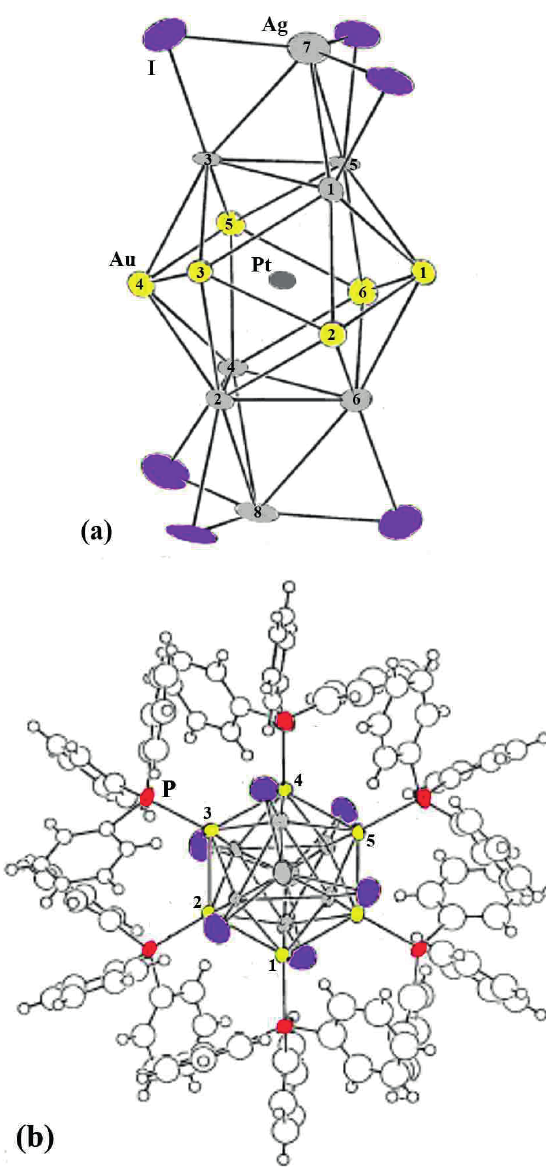
) Au Ag Pt{Ag(µ-I) 3 6 6 6